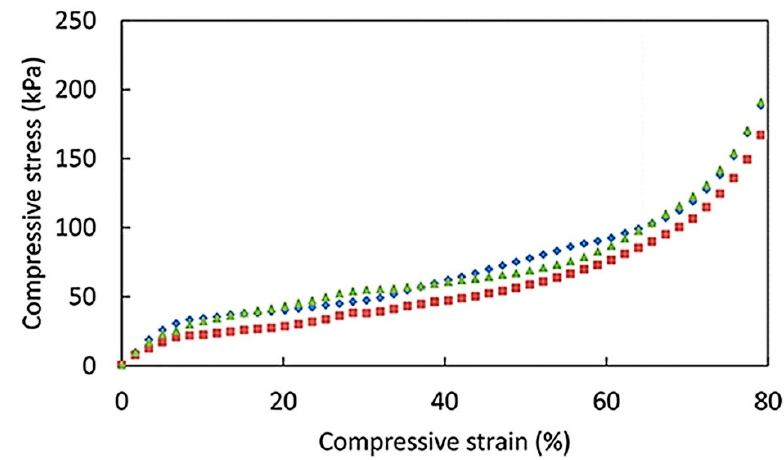
Figure 7. Stress − strain curves in compression for NFC (1 wt%) stabilized foam. The three samples are taken from different positions in the same dry foam (Adapted from Cervin and Johansson [7] with permission from Acs Appl Mater Interfaces).